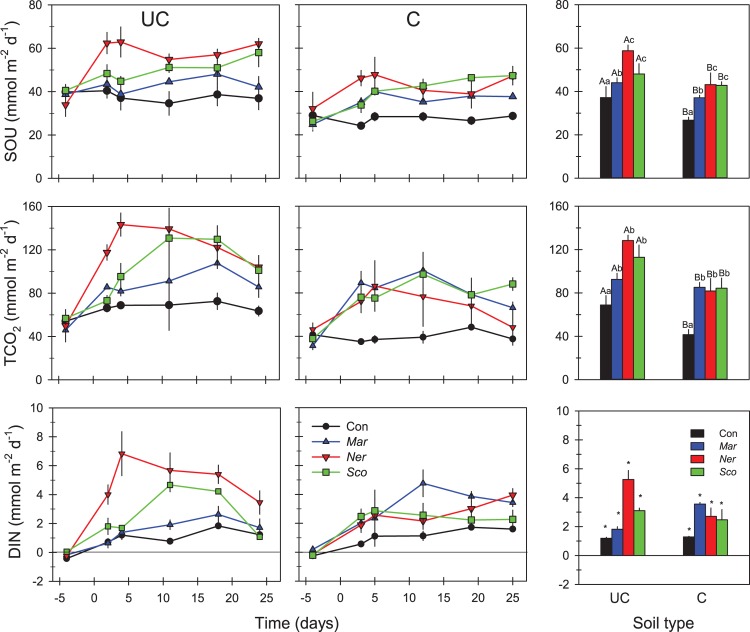
Sediment O2 uptake (SOU) and exchange of TCO2 and DIN in flooded uncultivated (UC) and cultivated (C) soil without (Con) and with added polychaetes (Mar: Marenzelleria viridis, Ner: Nereis diversicolor and Sco: Scoloplos armiger, respectively).Left and middle panels show temporal patterns and right panels show averages (from time of polychaete addition [t = 0] to end). Error bars indicate SE (n = 3). Capital and lower case letters in right panels represent the grouping of data obtained by 2-way ANOVA followed by Tukey post hoc analysis. Capital letters indicate significant difference between UC and C. Lower case letters indicate significant difference between core treatments (Con, Mar, Ner and Sco). * indicates significant interaction between the factors soil type and core treatment.